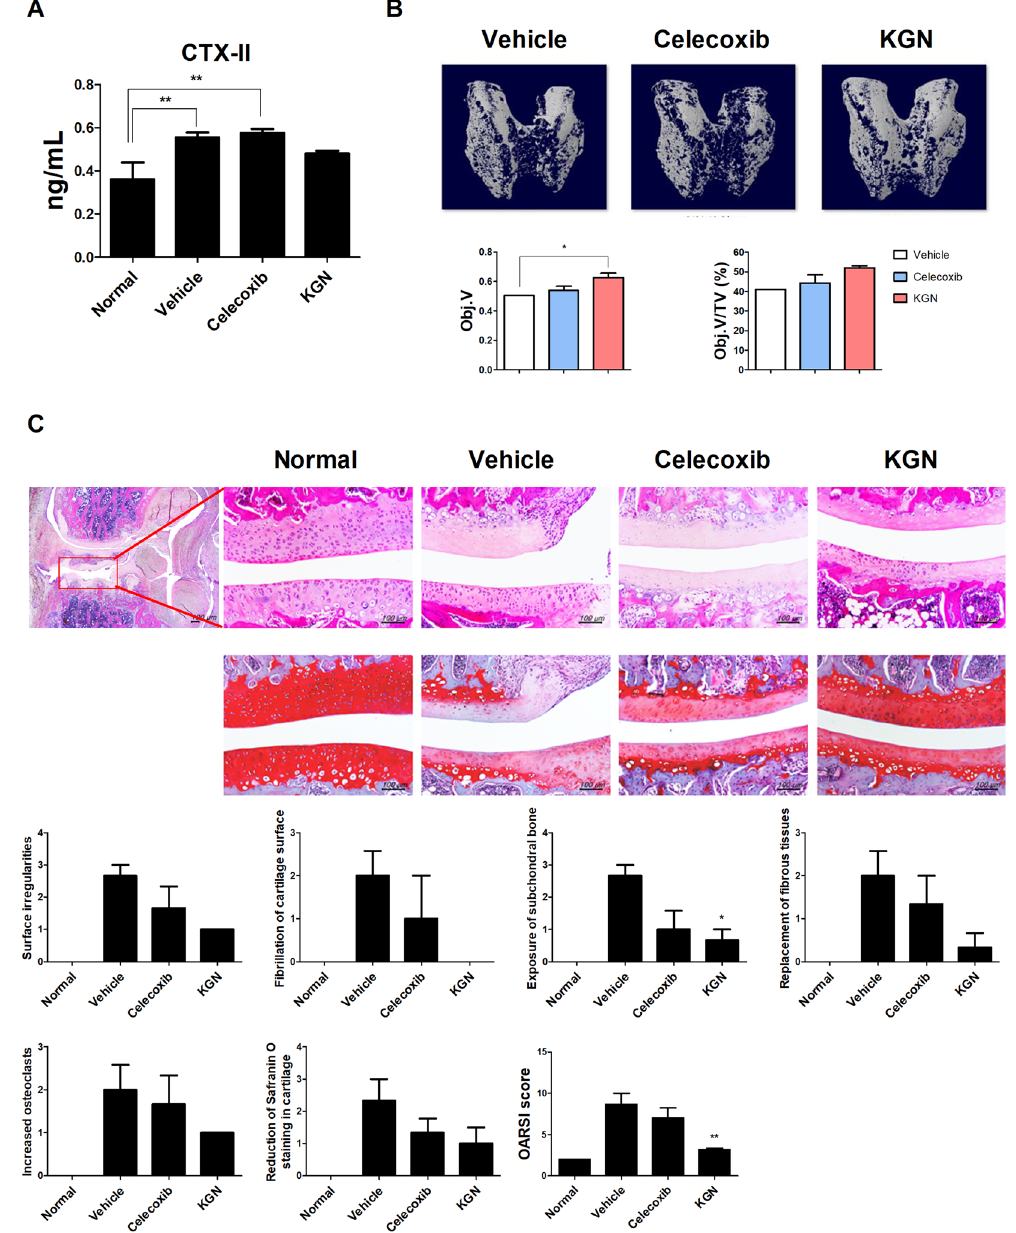
Figure 2. Degenerative disorder of the joint after treatment with KGN in OA model. ( A ) Serum sampling was made at 14 d after MIA injection in rats. Serum CTX-II levels were analyzed by enzyme-linked immunosorbent assay (ELISA). ( B ) Representative micro computed tomography (CT) appearances of the femur condyles at 14 d OA rat models. TV and Obj.V of micro-CT images from femur. ( C ) Histologic examination of the cartilage from rat with OA in each group. Tissue analysis was carried out two times in three animal models. These experiments were performed in 5 individual animal experiments. * P < 0.05, ** P < 0.001, comparison to